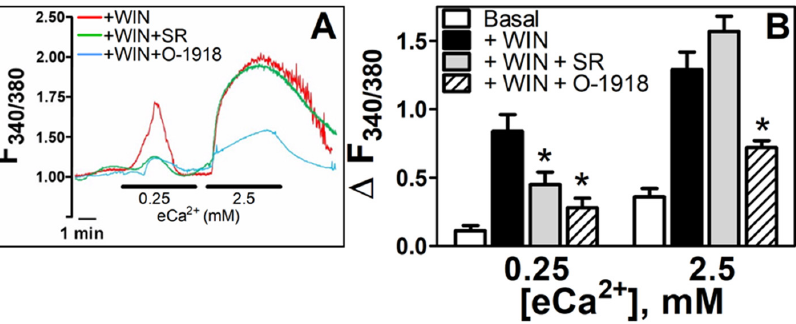
Figure 5. WIN55212-2-mediated increase in [Ca 2+ ] i is dependent on the CB 1 receptor and on nonCB 1 /CB 2 receptors. ( A ). Time course of the changes in F 340/380 in N18TG2 cells incubated in 0.25 and 2.5 mM eCa 2+ in the presence of WIN55212-2 5 μ M (+WIN, red line), SR141716 1 μ M (+WIN + SR, green line) and WIN55212-2 plus O-1918 10 μ M (+WIN + O-1918, light blue line). ( B ). Increases in [Ca 2+ ] i in low (0.25 mM) and high (2.5 mM) eCa 2+ in basal conditions (Basal, open bars, n = 6), in the presence of WIN55212-2 (5 μ M) (+WIN, n = 7), in the presence of WIN55212-2 plus SR141716 (1 μ M) (+WIN + SR, n = 7), and in the presence of WIN55212-2 plus O-1918 (10 μ M) (+WIN + O-1918, n = 5). * p < 0.05 vs. +WIN. 4. Discussion The aminoalkylindole WIN55212-2 can modulate [Ca 2+ ] i in neuroblastoma cells via at least two mechanisms. At low eCa 2+ , the WIN55212-2 induced potentiation of [Ca 2+ ] i par- tially depends on CB 1 R defined by its sensitivity to inhibition by SR141716. At supra-phys- iologic eCa 2+ , which activates the CaSR, the effect of WIN55212-2 is CB 1 R-independent. At both eCa 2+ levels, the release of Ca 2+ is from intracellular stores filled by store-operated Ca 2+ channels. We observed that the effect of WIN55212-2 on [Ca 2+ ] i depends on the eCa 2+ level. At low eCa 2+ , WIN55212-2 increases [Ca 2+ ] i acting via CB 1 R and nonCB 1 /CB 2 receptors, prob- ably acting on different intracellular transduction pathways. Actions of CB 1 R through per- tussis toxin-sensitive G i/o proteins leading to inhibition of cAMP production were first demonstrated in N18TG2 neuroblastoma cells [38]. CB 1 R acting through G α i could serve a modulatory role, as has also been proposed for G α q signaling, in mediating [Ca 2+ ] i in- creases in these cells [12]. The requirement for G α q on increasing [Ca 2+ ] i after CB 1 R activa- tion was demonstrated in HEK293 cells and hippocampal neurons [6]. Our results of an eCa 2+ -dependent elevation in [Ca 2+ ] i confirm a role for CaSR in the modulation of [Ca 2+ ] i in N18TG2 neuroblastoma cells, as previously demonstrated [12]. The effects of WIN55212-2 we report at low and high eCa 2+ were attenuated by SOCE blockade, suggesting that WIN55212-2 promotes the release of Ca 2+ from intracellular stores. The main transduction pathway associated with this particular increase in [Ca 2+ ] i is described as dependent on G α q , phospholipase C (PLC) activation, synthesis of diacyl- glycerol (DAG), and inositol triphosphate (IP 3 ) with further activation of ER IP 3 receptors promoting Ca 2+ release [11]. PLC can be activated by either G α q or G i/o βγ subunits, with these two effectors interacting with distinct regions of PLCs; G α q binds to the C-terminal and G βγ binds to the catalytic domain [39]. G α q and G i/o βγ can cooperate synergistically, increasing [Ca 2+ ] i after GPCR activation [40]. Recently a role for G i/o βγ subunits as modu- lators of G α q activation of PLC, forming a G α q -PLC-G i/o βγ complex, and depending on the affinity for the plasma membrane of the γ subunits has been proposed [41]. Regarding potential interactions between CaSR- and cannabinoid-dependent pathways modulating [Ca 2+ ] i , it is conceivable that WIN55212–2-dependent CB 1 R activation increases [Ca 2+ ] i by augmenting CaSR-G α q -dependent activation of PLC with the participation of CB 1 R-medi- ated G i/o βγ release in neuroblastoma cells.